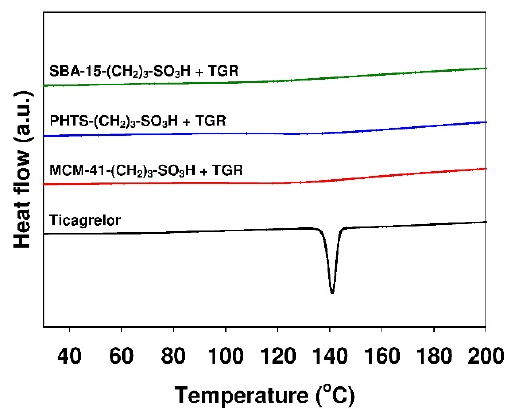
Figure 10. DSC curves of various mesoporous silicas loaded with ticagrelor.